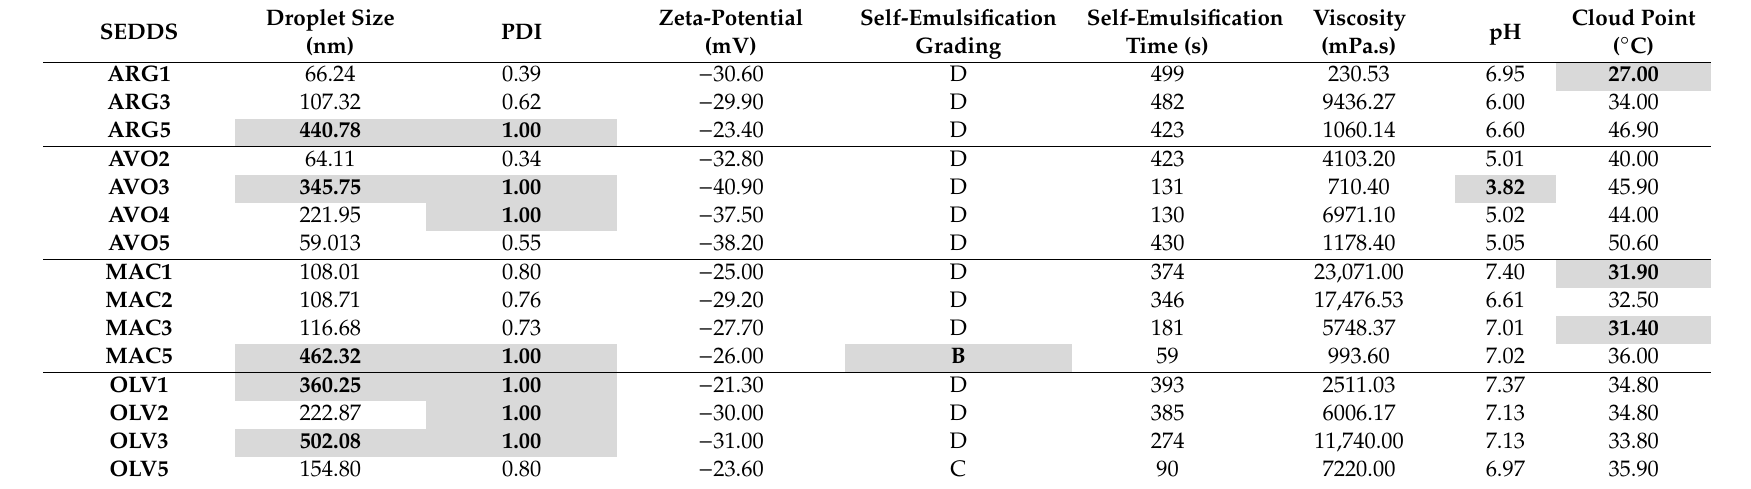
Table 3. Characterization profiles of topical SEDDSs that did not display phase separation after a period of 24 h at an ambient temperature. Characteristics that did not meet the criteria for the specific experiment conducted, are indicated in bold and